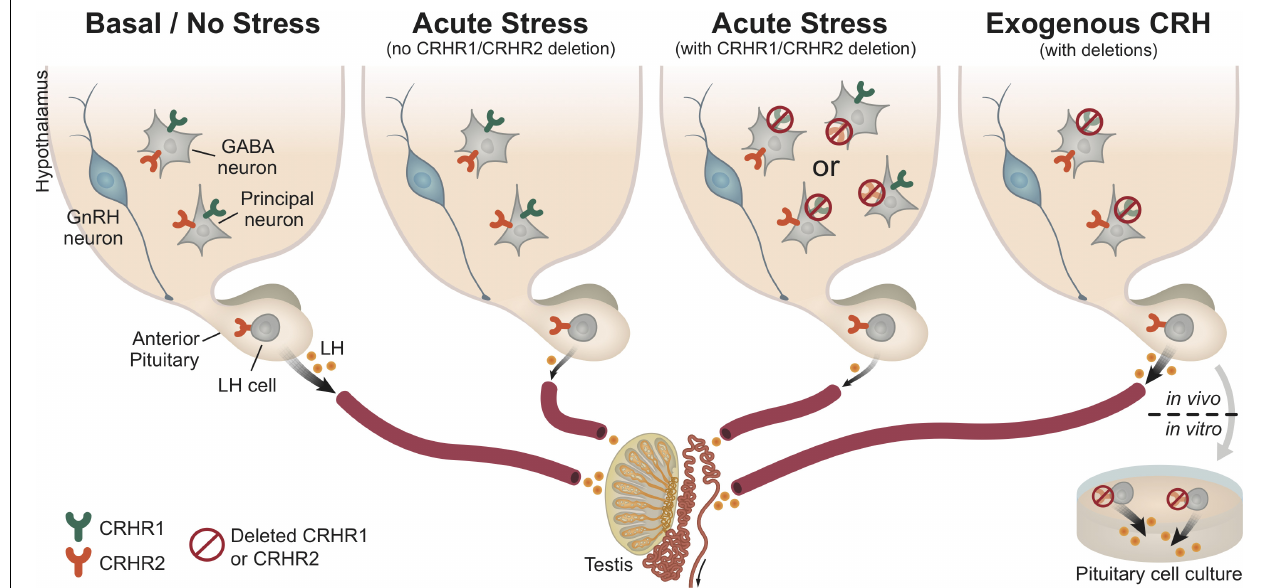
FIGURE 8 | Central and pituitary CRH receptor signaling in the regulation of HPG axis activity. This schematic diagram summarizes our results and represents a working hypothesis regarding the distinct role of CRH receptors, at the pituitary and brain levels, under basal (non-stressful) and stressful conditions. As depicted in the first panel (from left to right), under basal conditions (no stress) the HPG axis demonstrates functional activity, which ultimately leads to normal LH release by gonadotropes (LH cells) in the pituitary. However, under acute stress (such as restraint stress or LPS injection; second panel), the HPG axis is disrupted (at all levels), resulting in reduced LH release. Interestingly, upon acute stress and deletion of either central CRHR1 or CRHR2 (third panel), but keeping CRHR1 and CRHR2 receptors at the pituitary level, we showed that the stress-induced LH release was also reduced. This finding indicates that upon stress the suppression of the HPG axis is not merely mediated through central CRHRs, but that other factors seem to be recruited and be responsible for the suppression of LH release. The last panel shows that CRH signals differently in the pituitary than in the brain: specifically, the deletion of CRHR2 (but not CRHR1) in the pituitary prevents the suppression of LH release from the pituitary ( in vitro : pituitary cell cultures after stimulation with CRH), whereas the application of CRH ( in vivo : i.c.v. infusion into the lateral ventricle) in unstressed mice lacking the CRHR1 (but not CRHR2) centrally also prevents the suppression of LH release. Both CRHR1 and CRHR2 are depicted in the same neurons for illustrative